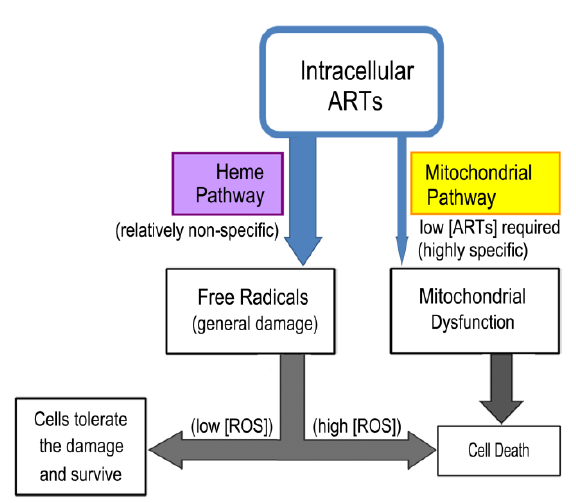
FIGURE 4: Two distinct pathways for the action of ART. One ac- tion (the heme-mediated pathway) is non-specific and the other (mitochondrial action) is specific. In most types of cells such as mammalian cells, only the non-specific action exists. In other types of cells such as malarial parasites and Baker’s yeast cells, the anti-mitochondrial action exists and their mitochondria are sensi- tive to the action of ARTs. When both of these two actions exist, suppressing the heme-pathway will potentiate the mitochondrial action. This is because ART is consumable and by reducing ART degradation through heme’s action, more ART may be available to the action of